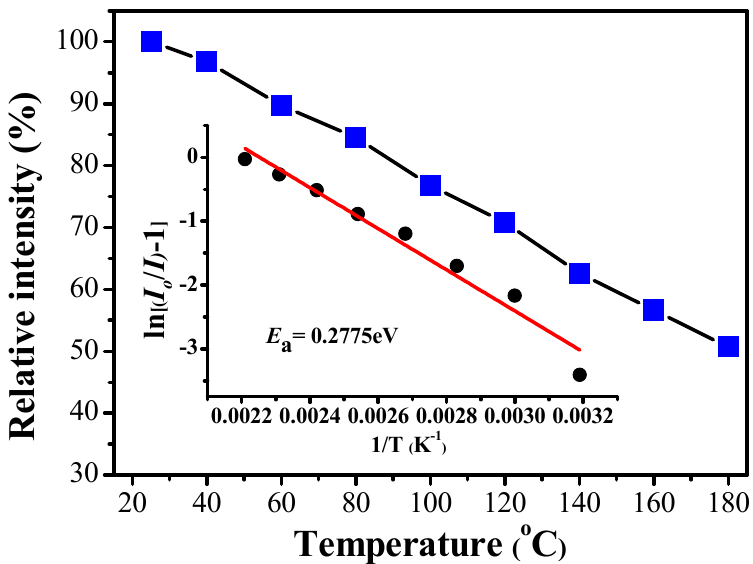
Figure 4. The relative PL intensity of the polymer as a function of temperature. The inset represents the ln[( I o / I ) − 1] versus 1/ T and the calculated activation energy ( E a ).